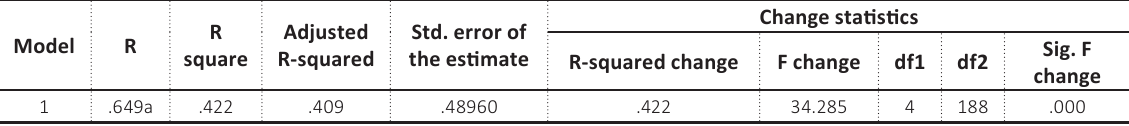
Table 2. Model summary